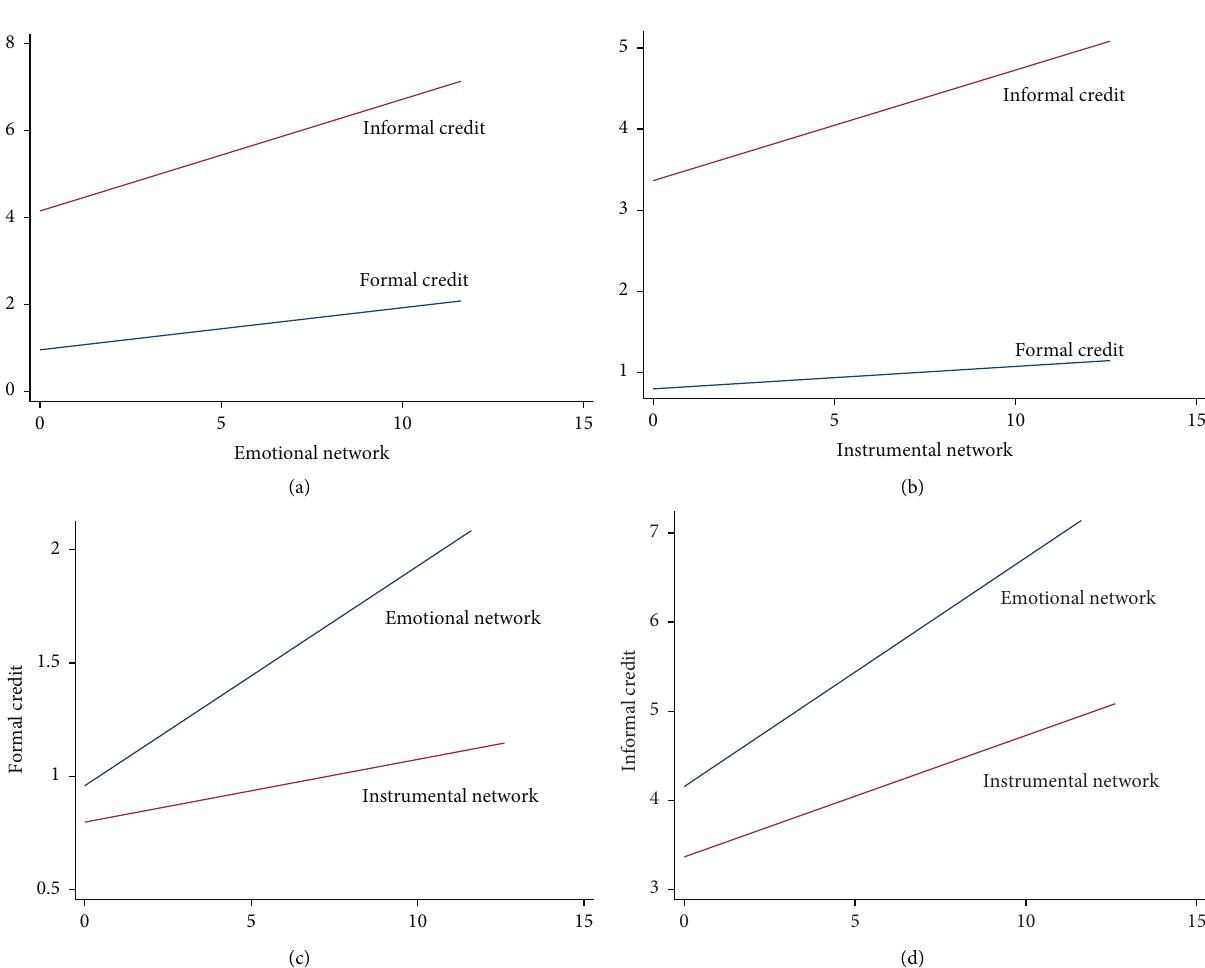
Figure 5: Slope graph of social networks effect on credit behavior. (a) Emotional networks and (b) instrumental networks effect on formal and informal credit. Emotional networks and instrumental networks effect on (c) formal and (d) informal